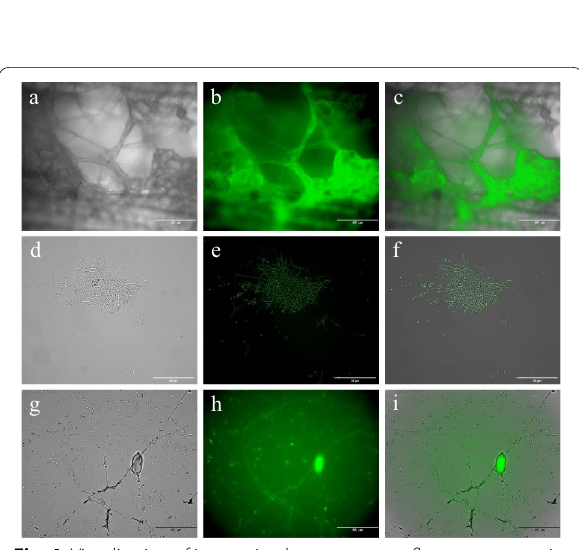
200 ( a – c ) and 50 μm ( d – f ) =